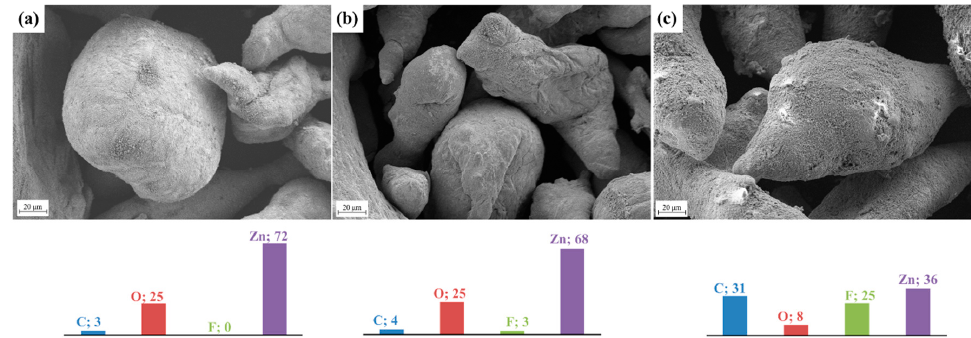
Figure 1. Field emission scanning electron microscopy (FE-SEM) images (SE2, 20 μ m scale) and energy dispersion spectrometry (EDS) (color bars in wt. %) of ( a ) uncoated; ( b ) 1 wt. %; and, ( c ) 5 wt. % Nafion ® -coated zinc particles (ICZP).